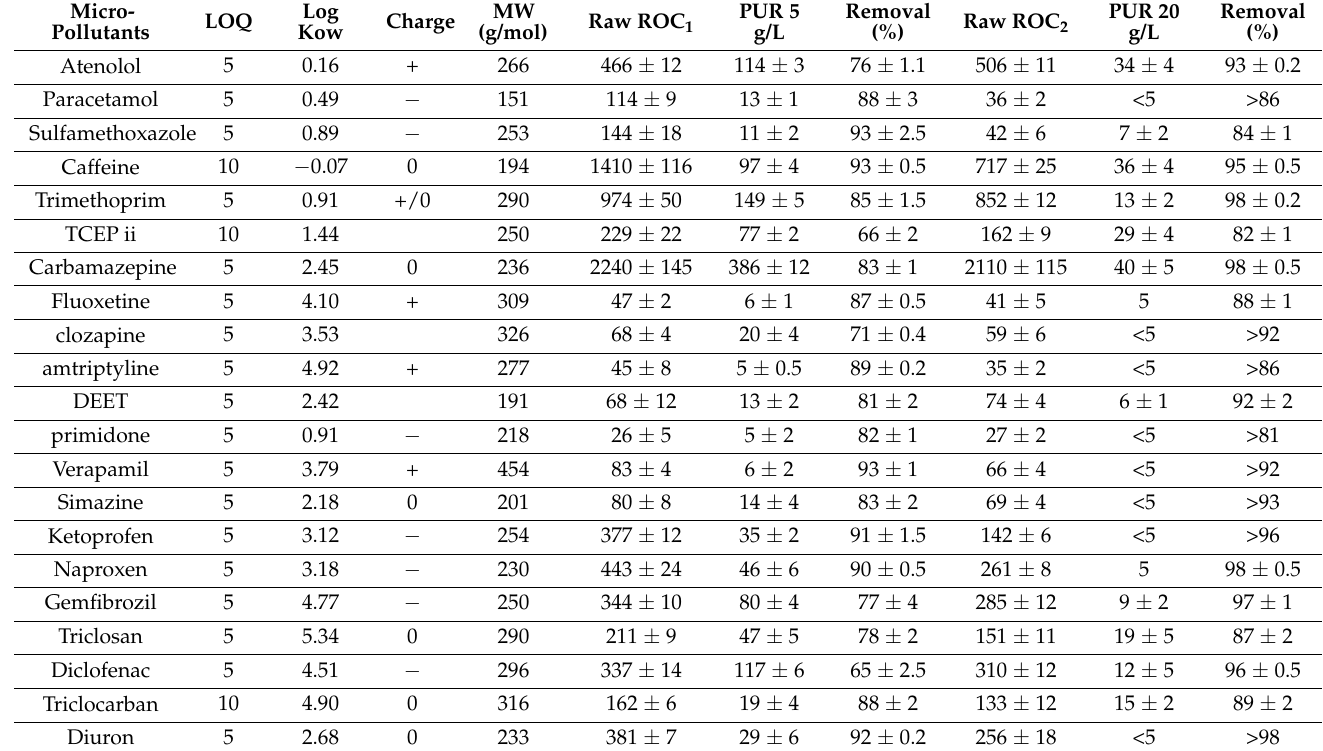
Table 6. Removal of micro-pollutants using the MF–IEX hybrid system